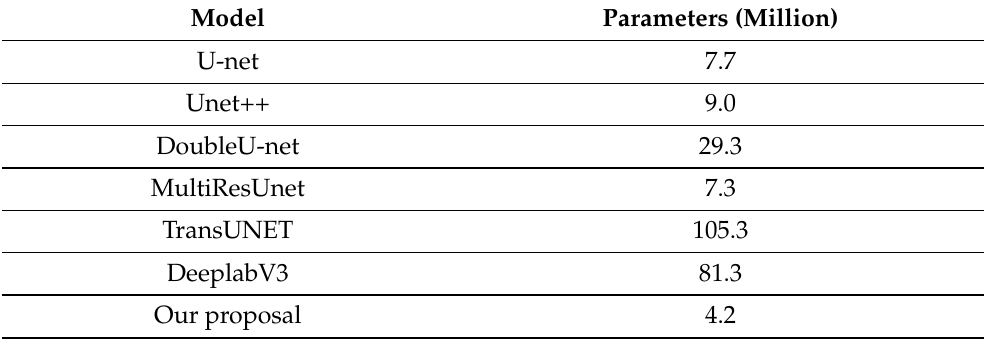
Table 4. Parameter comparison with the previous